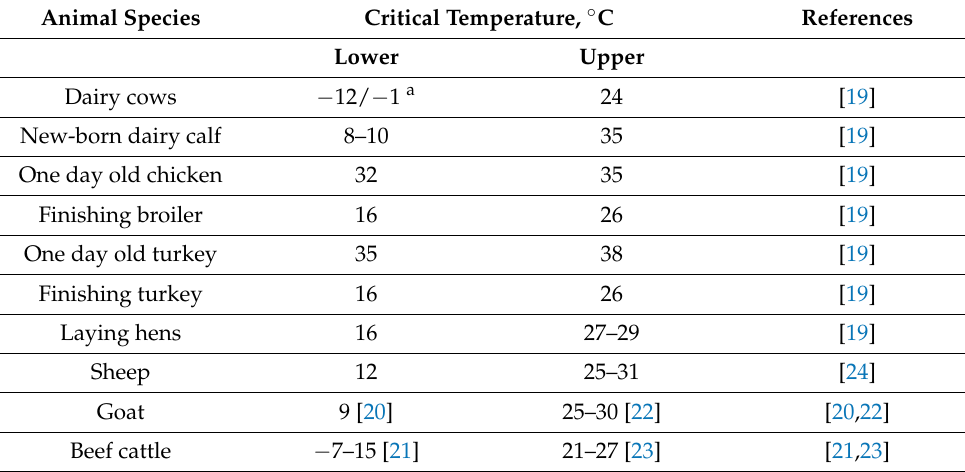
Table 1. The lower and upper critical temperatures for different animal